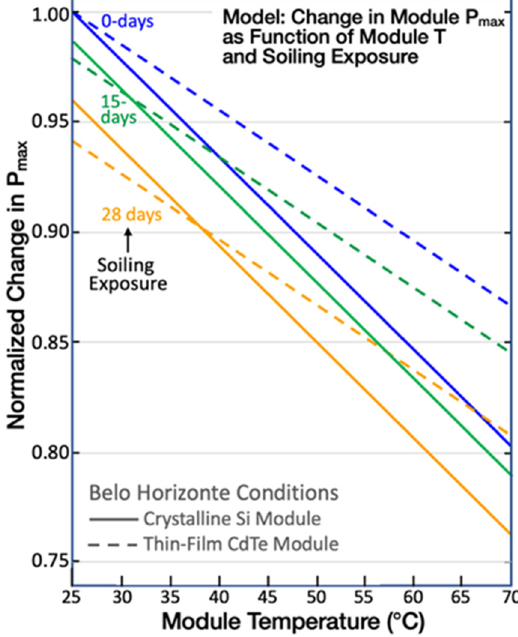
Figure 4. Modeling of normalized change in P max as function of module temperature for various module soiling exposure times, comparing Si with thin-film CdTe module.